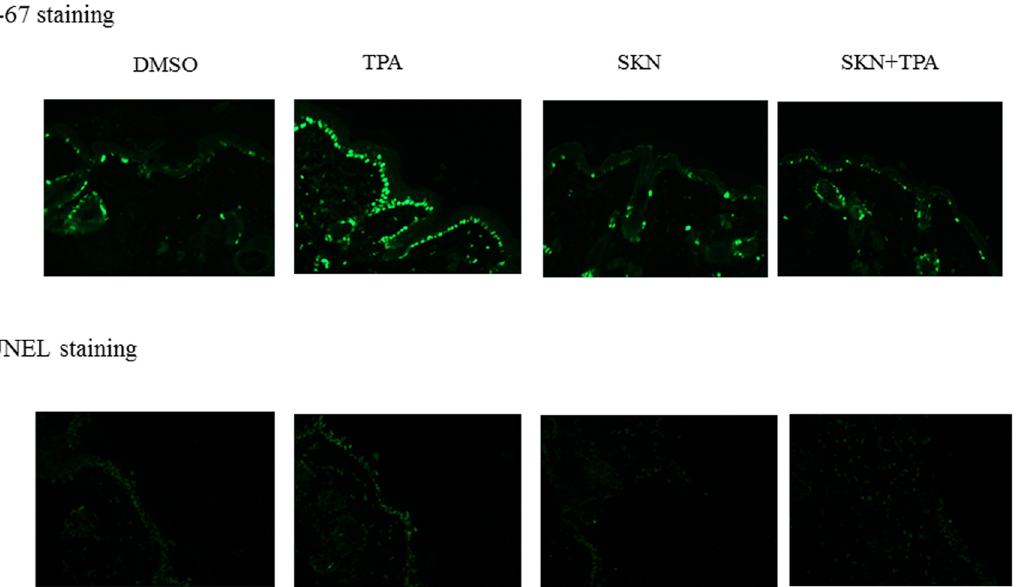
Fig 1. Ki-67 and TUNEL staining of skin epidermal tissues at the end of the skin carcinogenesis study (amplification: 20x). Ki-67 and TUNEL staining was performed according to the manufacturer ’ s instructions. A representative image from each treatment group was shown. DMSO, DMSO-treated group; TPA, DMBA/TPA-treated group; SKN, shikonin-treated group; SKN+TPA, shikonin plus DMBA/TPA-treated group.